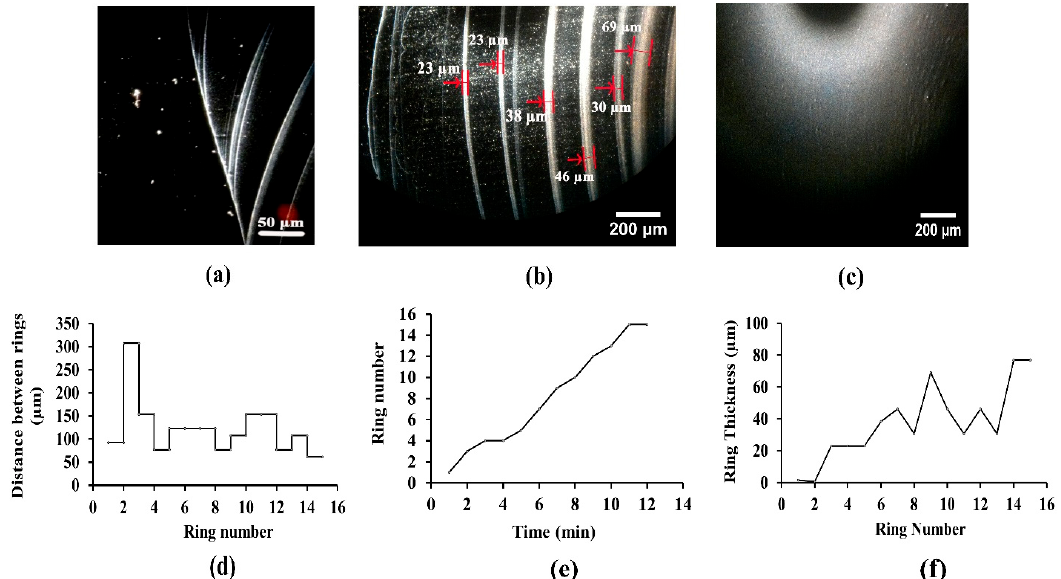
Figure 6. Patterns after drying of phage (dialyzed) with higher phage concentration (10 11 PFU/mL). ( a , b ) Multiple coffee rings and ( c ) inner dried regions. The coffee rings thicknesses are pointed by arrows in ( b ). The characteristics of coffee rings formed for the concentrated dialyzed phage suspensions are shown as ( d ) the distance between rings vs. the ring number; ( e ) the ring number vs. time; and ( f ) the ring thickness vs. ring number.